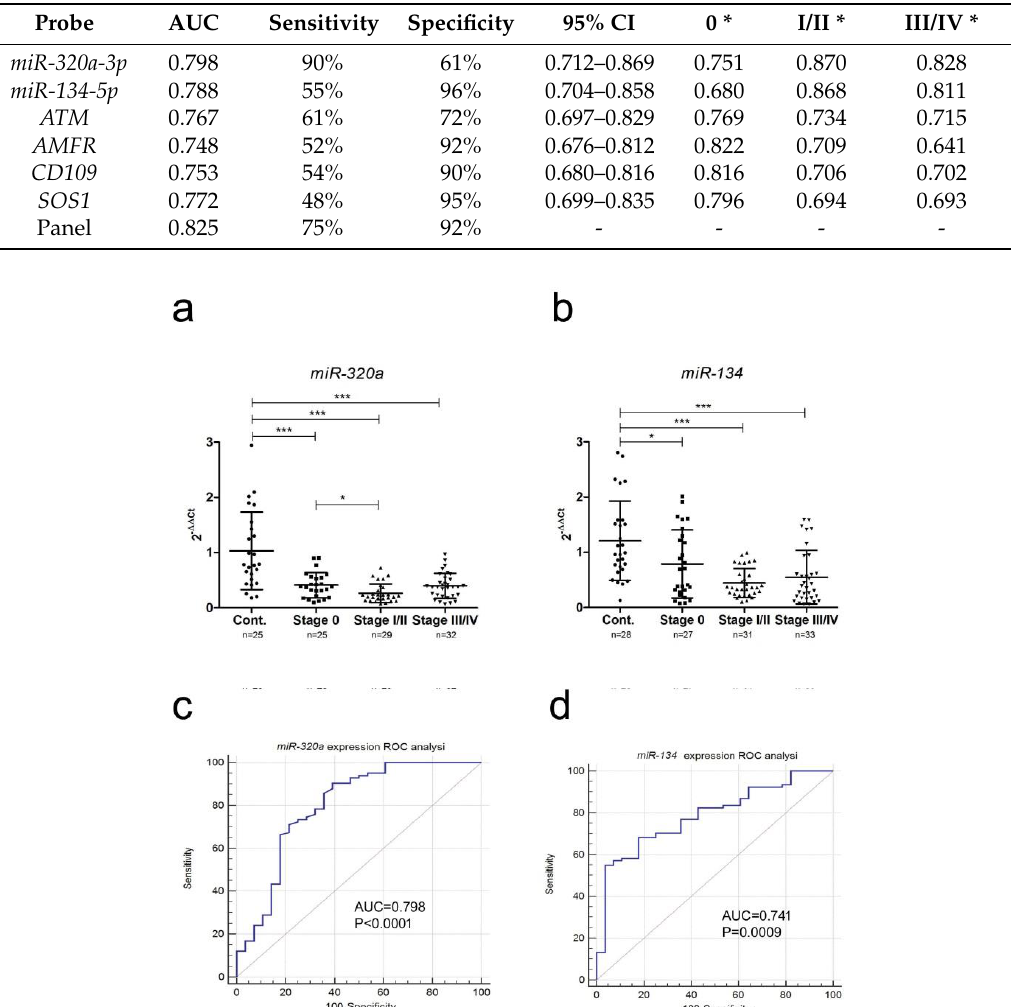
Figure 2. Expression levels of miRNAs measured by qRT-PCR in independent validation